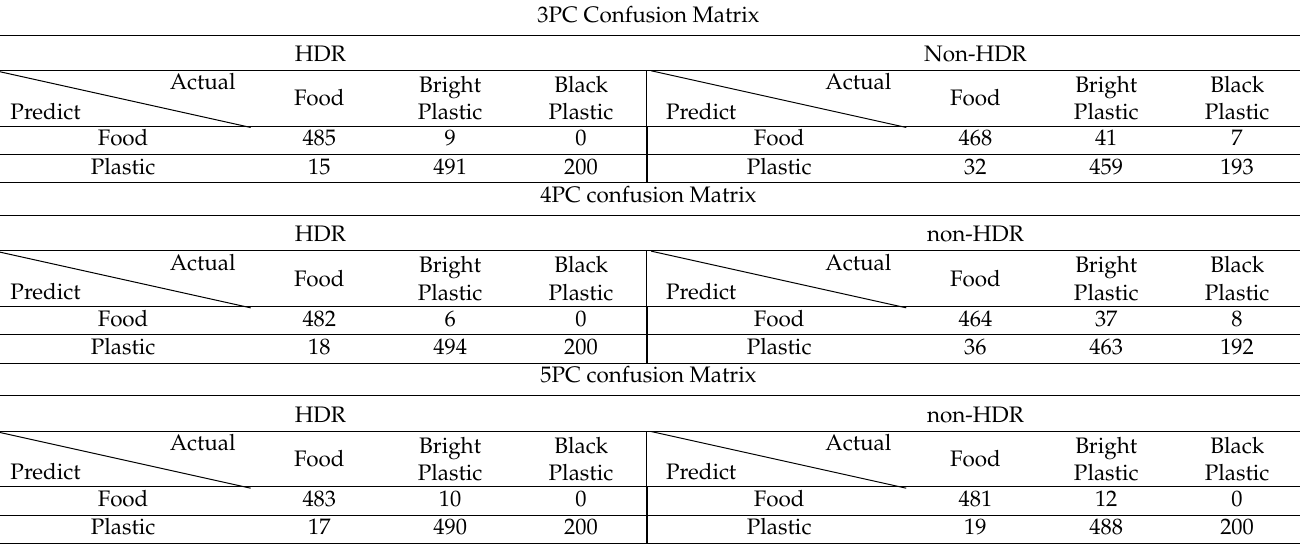
Table 6. Confusion matrices for HDR and non-HDR classification (test case 1) from 3 to 5 PC.